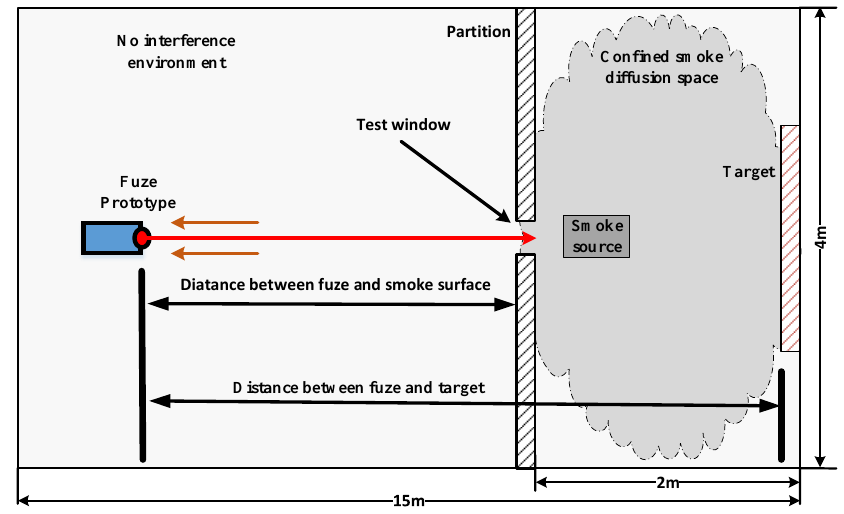
Figure 12. Schematic test scenario of fuze prototype under smoke interference. The smoke interference environment test was conducted in a closed room, and confined diffusion space was isolated by partitions.